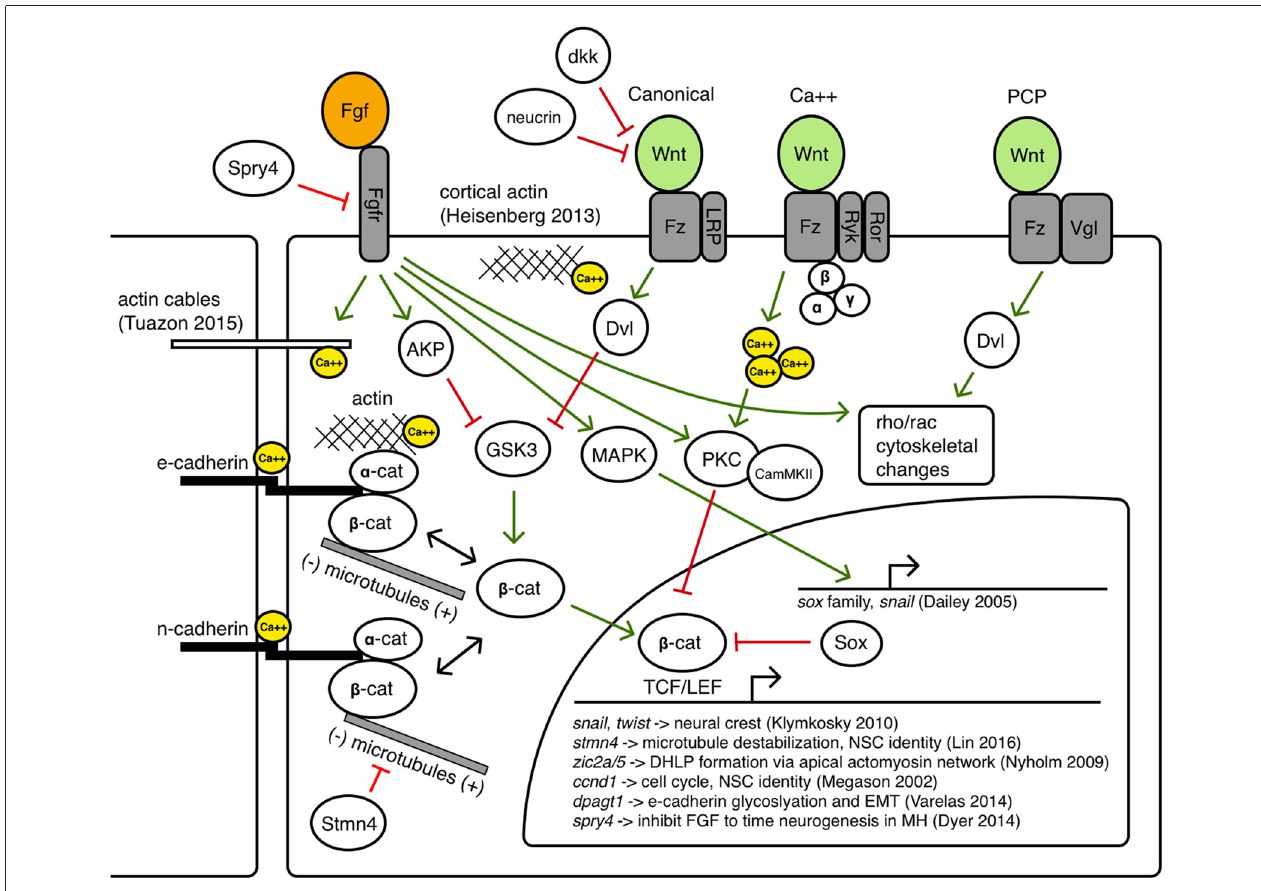
FIGURE 5 | Potential avenues of Wnt/Fgf signaling contributing to MH